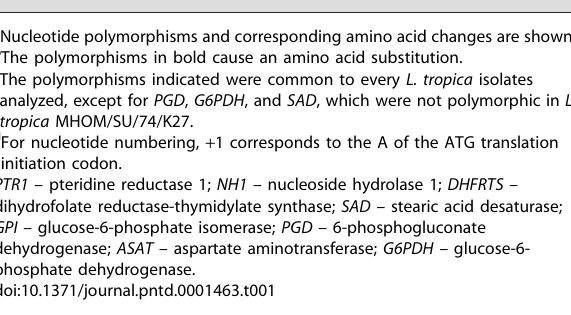
The isolates were further characterized on the basis of the pteridine reductase 1 (PTR1) sequence [17]. PCR fragments of the coding region of PTR1 were amplified from genomic DNA extracted from the clinical isolates and sequenced. The sequences generated were compared to those of eight Leishmania reference strains and were shown to be closely related to L. tropica sequences (data not shown). A neighbor-joining phylogenetic analysis generated from the translated PTR1 sequences further confirmed that the four CL strains derived from Canadian soldiers were L. tropica parasites (Fig. 2).